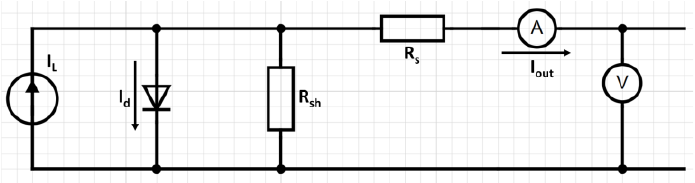
Figure 9. Photovoltaic cell equivalent circuit.